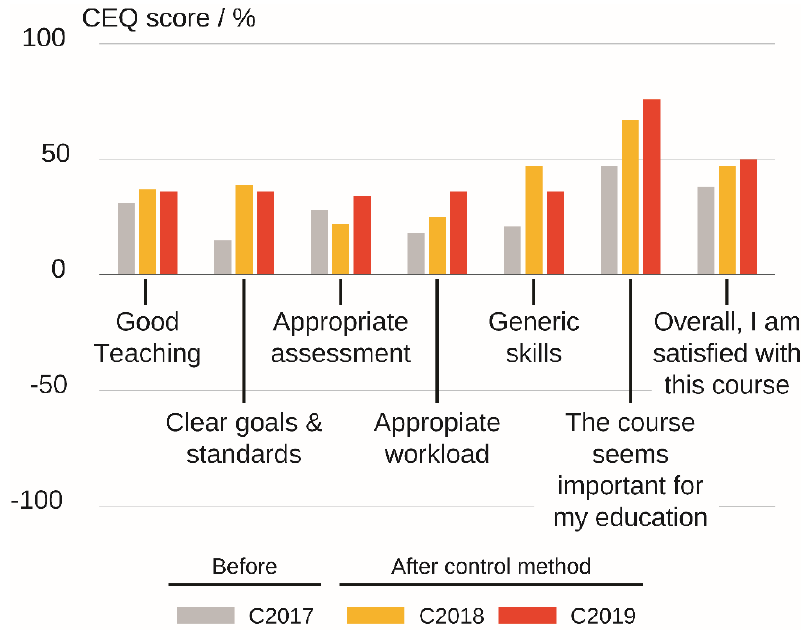
Figure 8. Results of Course Evaluation Questionnaires (CEQ) for the three classes considered in the evaluation.